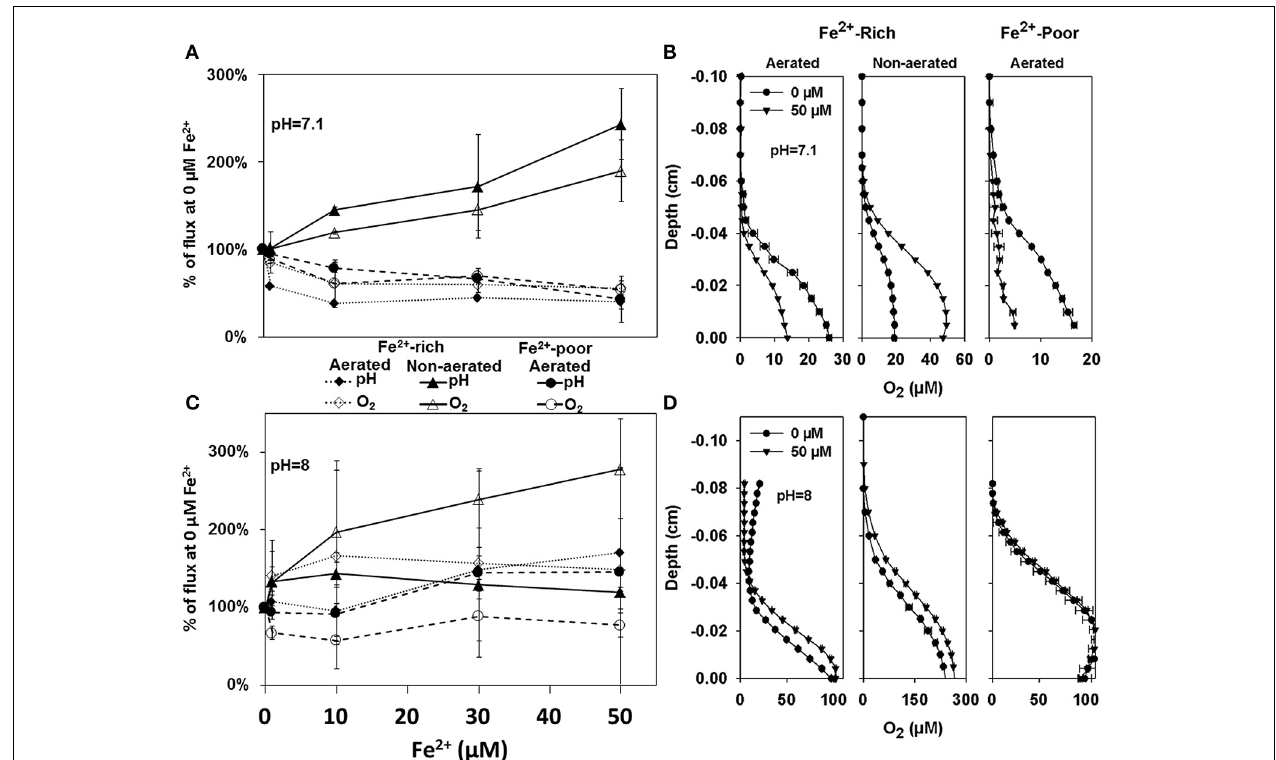
FIGURE 3 | Percent change in O 2 fluxes and pH gradients calculated from microprofiles measured in cyanobacterial biofilms grown from enrichment cultures from the Fe 2 + -rich and Fe 2 + -poor reactors at pH 7 (A) and pH 8 (C). The shown fluxes